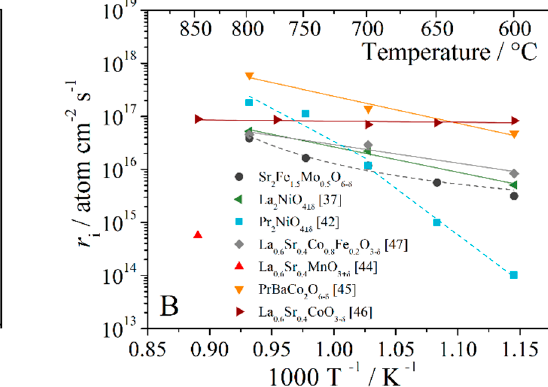
Figure 7. Temperature dependences of the rate of oxygen adsorption ( A ) and oxygen incorporation ( B ) for some oxides [37,42,44–47].